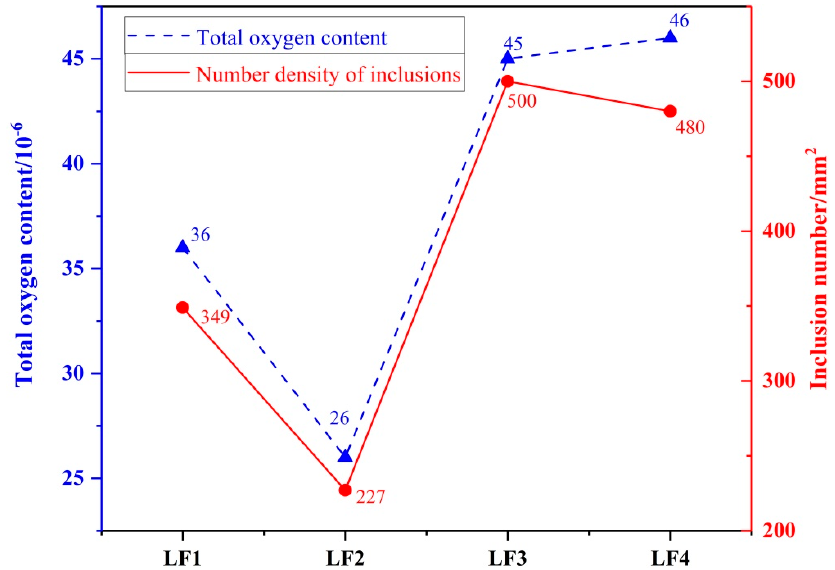
Figure 1. Graph showing trend in total oxygen content and the number density of inclusions.